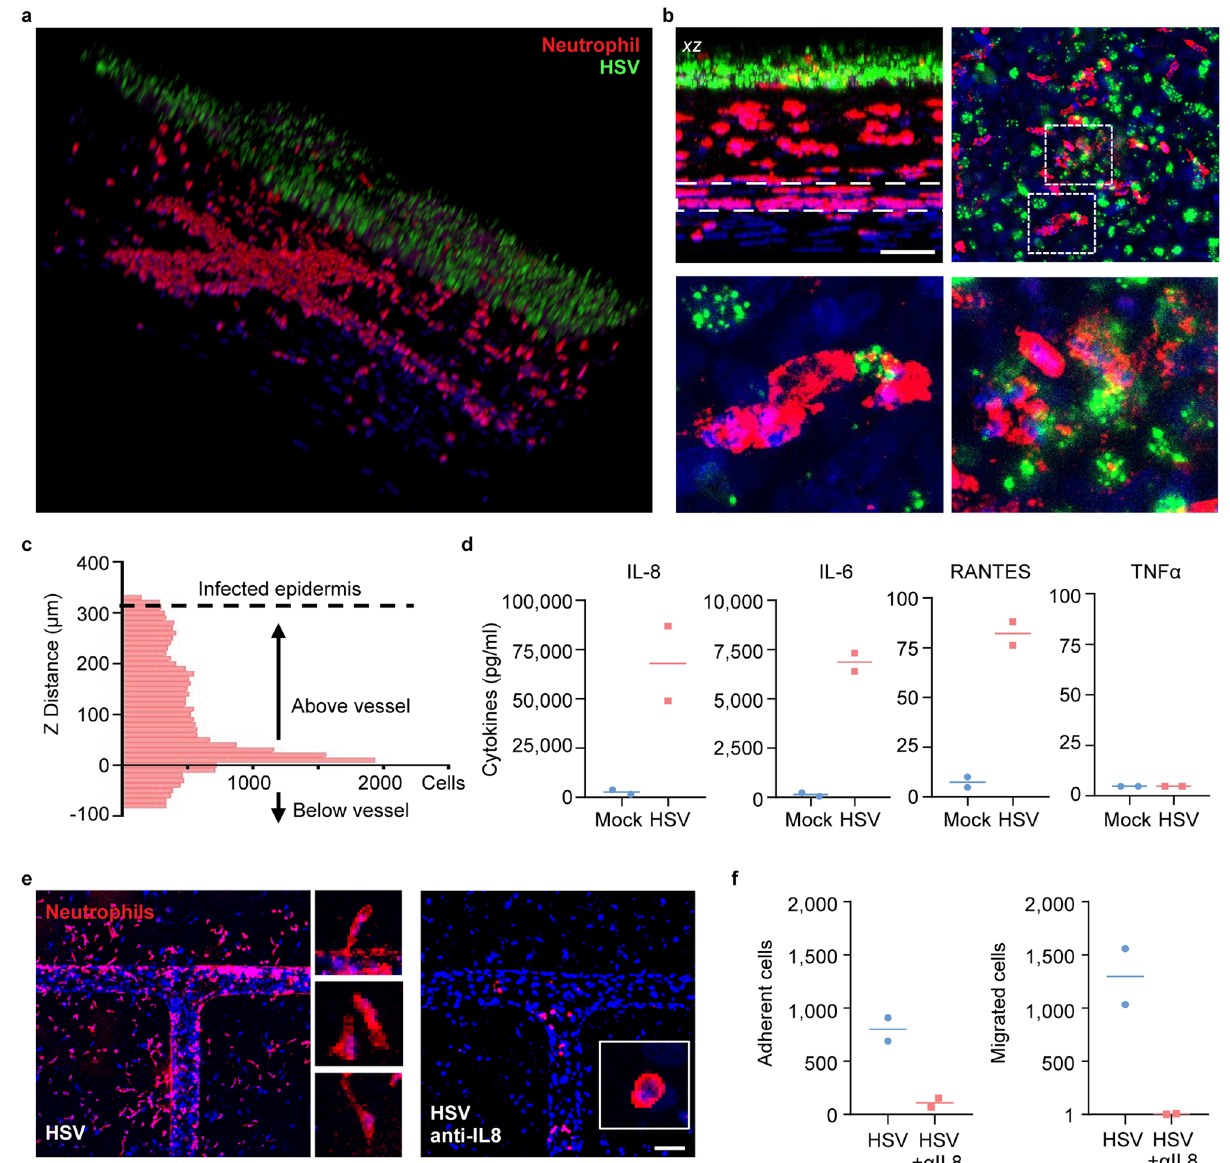
Fig. 5 | IL8-dependent directional migration of neutrophils towards infected epidermis.a Reconstructed3-Dconfocalimageshowingthespatialdistributionof in fi ltrating neutrophils(red, CD15) and HSV-infected epidermis (green) in the skin- on-chip. Neutrophils were perfused through the microvascular network 1h after the epidermis wasinfected with HSV-1K26 (10 6 PFU).Scale bar: 100 µ m. b Top left: Projected cross-sectional view of neutrophil (red) migration into the dermal space toward HSV-infected (green) epidermis in the skin-on-chip. Dashed line indicates the vessel wall. Top right: Horizontal view of in fi ltrating neutrophils in the HSV-1- infectedepidermis.Bottomrow:enlargedviewsofthedashedboxesshowingclose contacts between neutrophils and infected keratinocytes. c Quanti fi cation of neutrophil distribution in z distance. Z=0: neutrophils inside the vessel; Z>0: